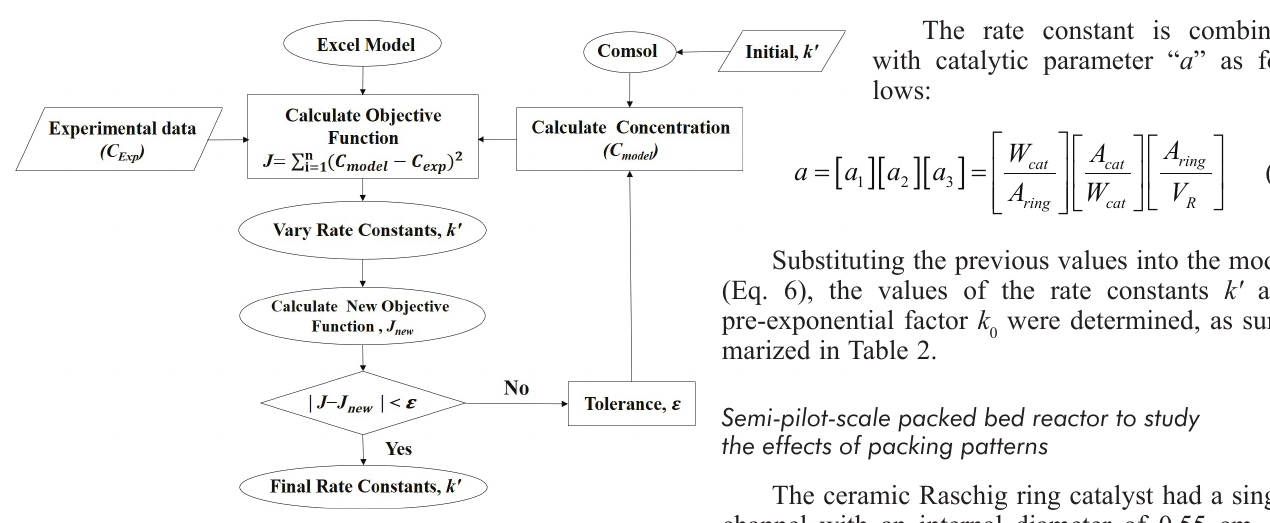
Fig. 1 – Schematic of numerical model optimization